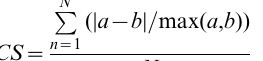
Dataset Climate regulation Flood regulation Pollination Erosion protection Recreation Datasets included in full